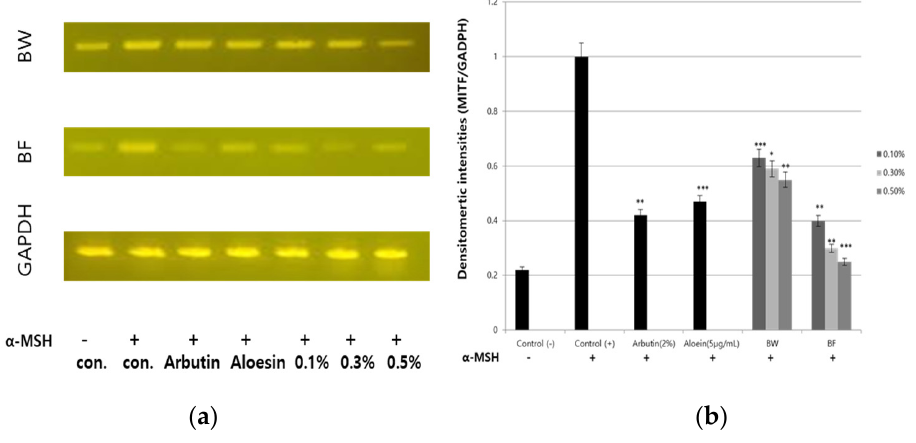
Figure 10. Downregulation of mRNA expression of MITF from α -MSH-treated B16F10 cells ( a ) and relative densitometric intensities corresponding to each PCR band normalized with a house keeping gene, GAPDH ( b ) in treating various concentrations of two extracts of aloe skin leaf, and 5 µ g/mL aloesin and 2% arbutin as positive controls. BW: Water extract of aloe skin leaf at 100 ◦ C for 24 h. BF: Fermented extract of aloe skin leaf fermented with L. plantarum BN41 at 37 ◦ C for 3 days and further extracted by an ultrasound generator at 20 kHz for 4 h. The mean values ± SD for separate triplicate experiments are shown, and error bars indicate the SD. The significance of the difference was set to * p < 0.05, ** p < 0.01 and *** p < 0.001 compared with the control (+).